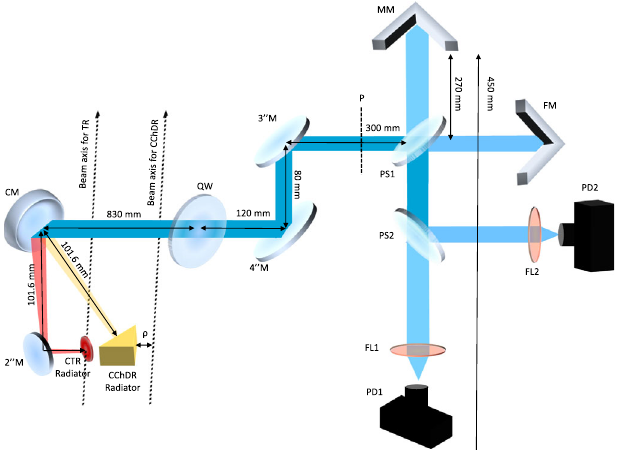
FIG. 11. Experimental setup for CChDR and CTR extraction and interferometry: CM — Concave Mirror; QW — Quartz Win- dow; 4 inchM — 4 inches Mirror; 3 inchM — 3 inches Mirror; P — Polarizer; PS1, PS2 — Polarizing beam Splitters; FM — Fixed Mirror, MM — Movable Mirror; PS2 — Polarizing beam Splitter; FL1, FL2 — Focusing Lenses with focal length 101.6 mm; PD1, PD2 — Pyroelectric Detectors (Gentec